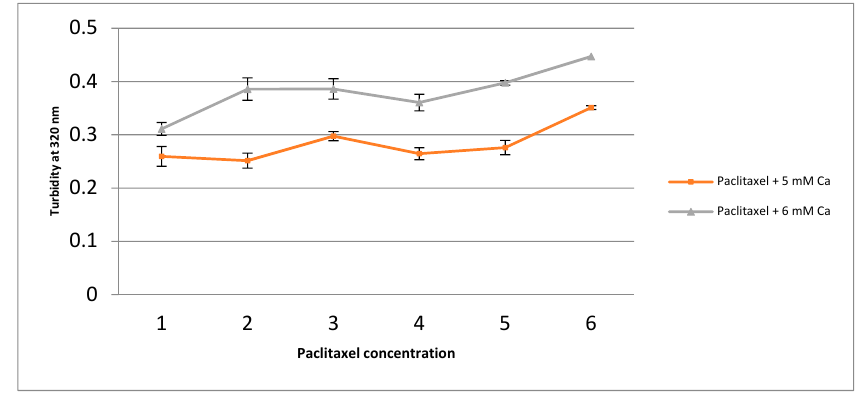
Figure 4. Apatite with or without drugs (0 to 100 μ M) were formed in bicarbonated medium with addition of 5 and 6 mM of exogenous calcium chloride in presence or absence of drugs, followed by 30 min incubation at 37 °C. After incubation, turbidity was measured at 320 nm against fresh media as a blank. Values for apatite were calculated by deducting values for the free drug at different concentrations. All experiments were performed in duplicate and data represents the mean ± SD.